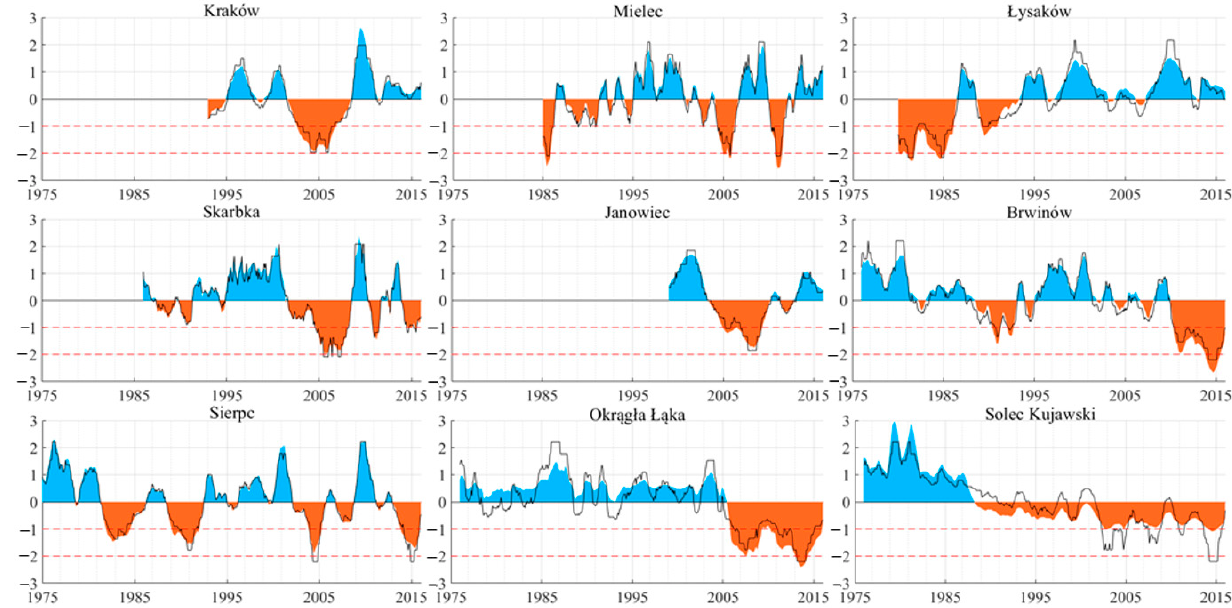
Figure 12. The SGI12 for nine wells within the Vistula basin area. Black lines denote non-parametric results whereas blue (wet) and orange (dry) areas denote the SGI12 obtained using gamma distribution to fit the data.